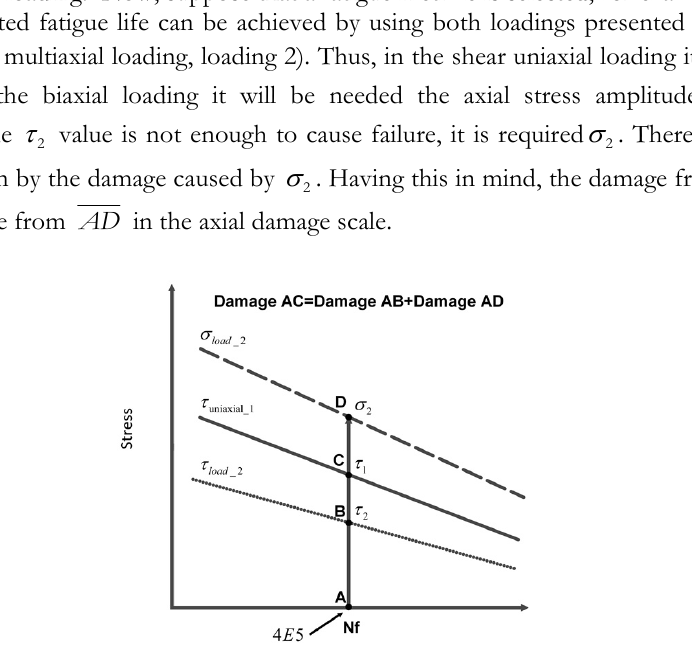
Figure 6: SFF damage scale